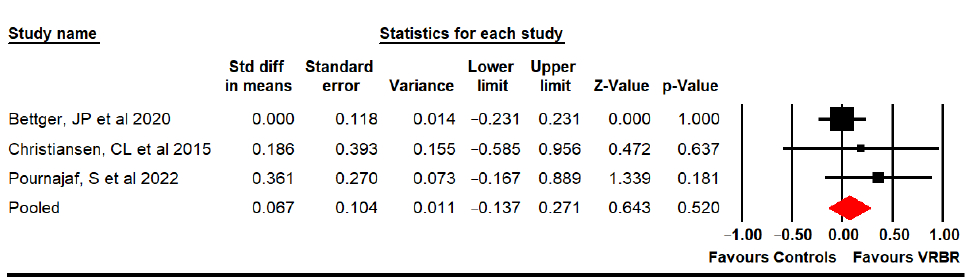
Figure 7. Forest plot of the immediate effect of VRBR on gait speed [58,59,69].